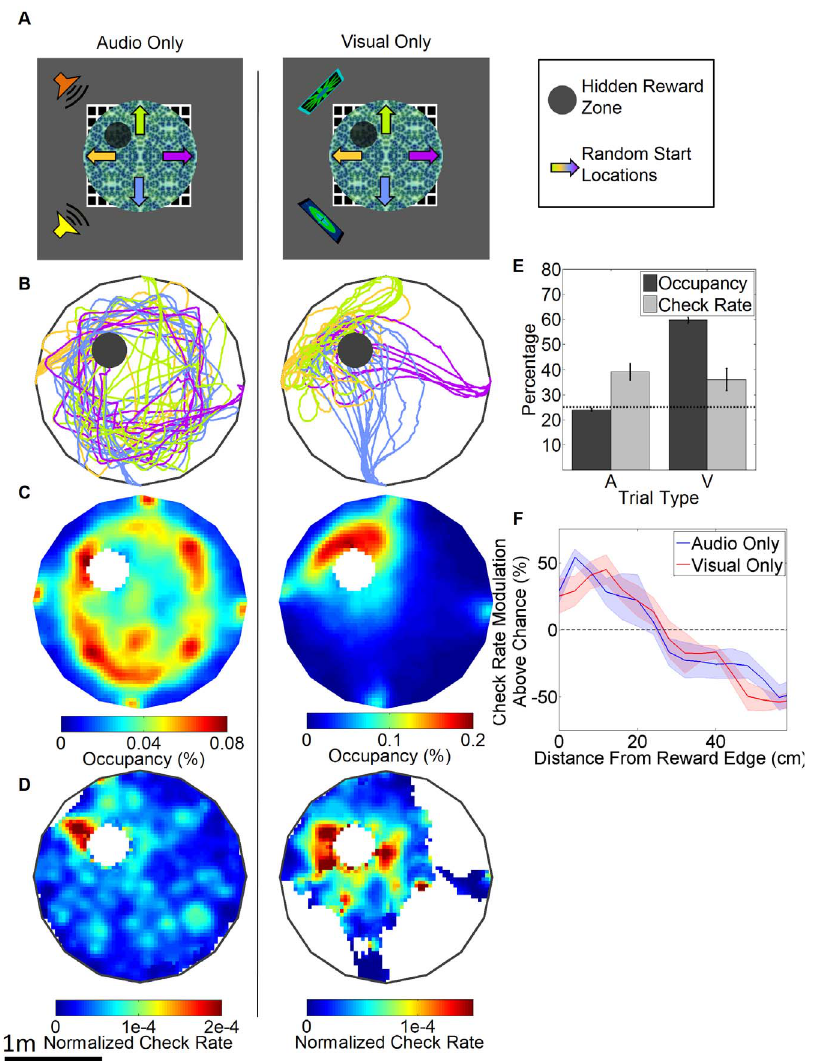
Figure 4. Navigational performance and reward checking during the auditory and visual virtual spatial navigation tasks. (A) Schematic of the auditory task and the visual task. Symbols as in Figure 3. (B) Example paths from each task. (C) 2-D histogram of occupancy averaged across rats over 4 sessions for each trial type. (D) 2-D histogram of the normalized check rate averaged across rats over these sessions. White areas indicate insufficient coverage. (E) Percentage of occupancy and check rate in the target quadrant for the two tasks. Two way ANOVA for effect target vs. other quadrants and auditory vs. visual trial types: Effect of quadrant F(1,8) =95.16, p , 0.001, Effect of task type: F(1,8) =2.08, p , 0.001, Interaction of quadrant and task type: F(1,8) =2.08, p=0.002; Effect of quadrant for auditory task: p=0.097, target quadrant percentage